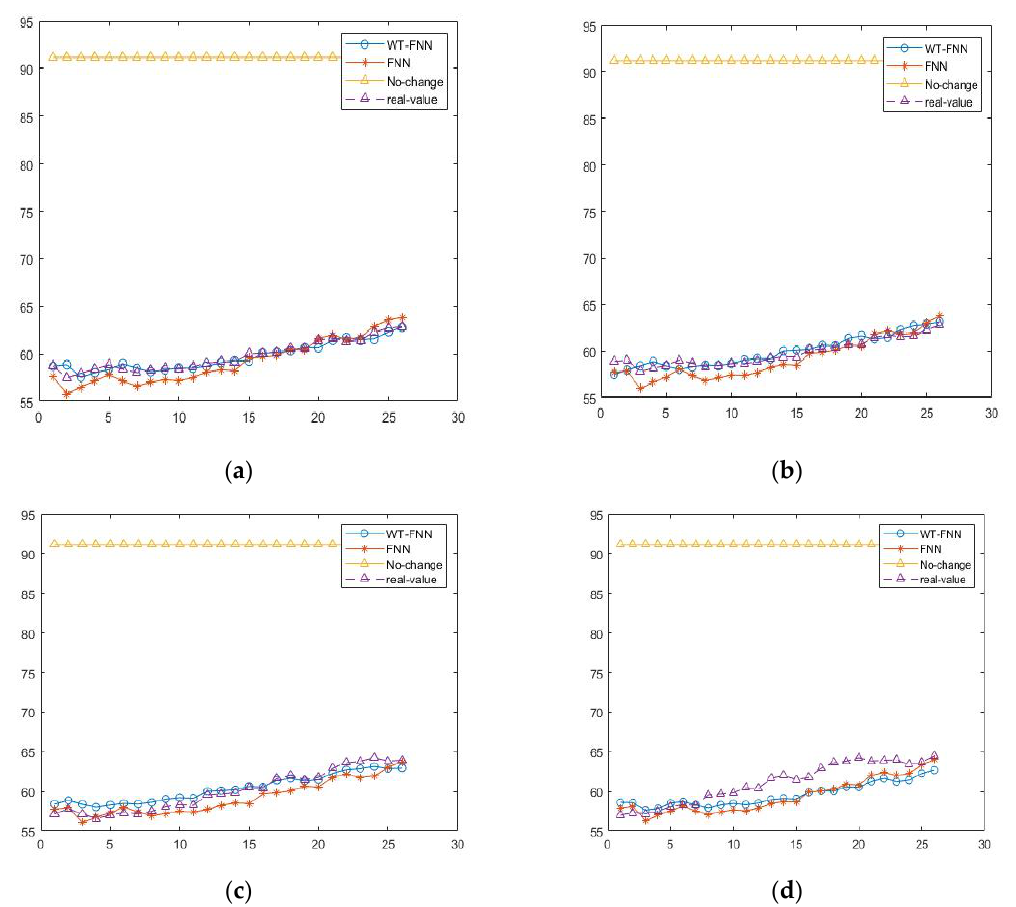
Figure 5. Comparisons of the part predictive data and the actual data for the models. ( a ) one-step; ( b ) two-step; ( c ) four-step ( d ) eight-step.